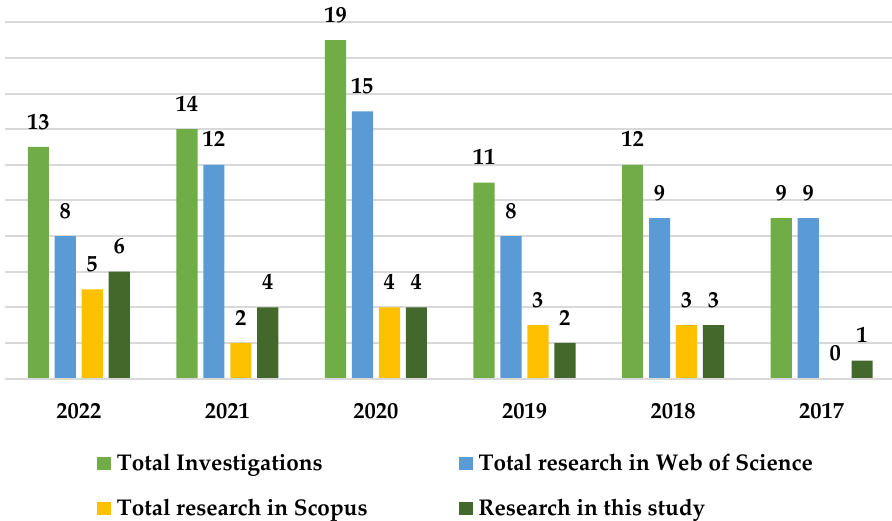
Figure 2. Evolution of scientific output of total articles and selected articles.